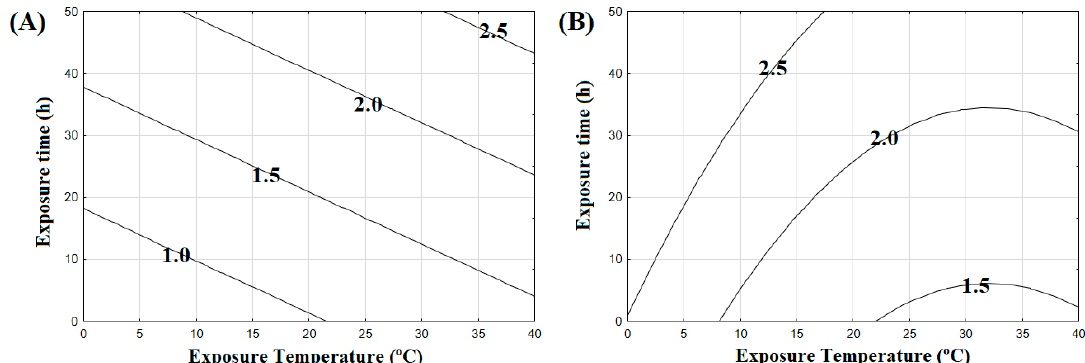
Figure 2. Iso-reduction plot drawn from the developed models, where each line describes an equivalent Log reduction of S . Typhimurium in ( A ) Brazilian dry-cured loin (BDL) as a function of temperature and time exposure (Equation (4)); ( B ) one-hour simulated gastric fluid (SGF)—exposure at pH 1.5 following Brazilian dry-cured (BDL) as a function of temperature and time exposure.